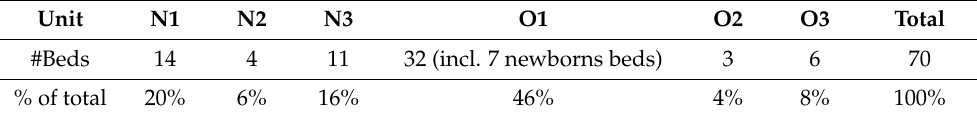
Table 2. The number of beds in the Perinatology Care